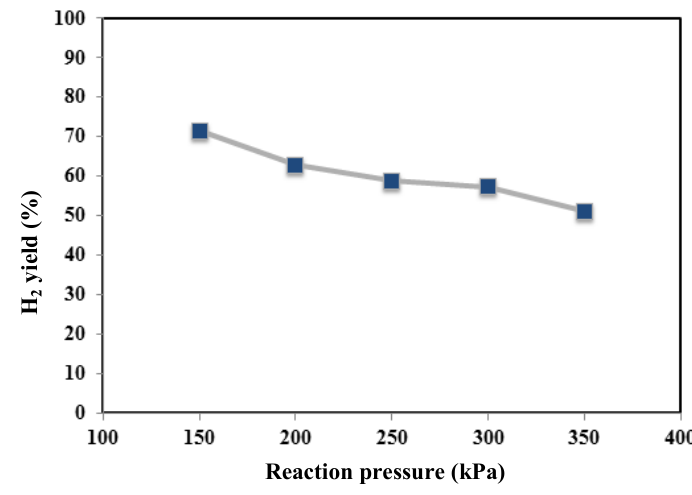
Figure 5. Hydrogen yield versus reaction pressure at 450 °C for MR.